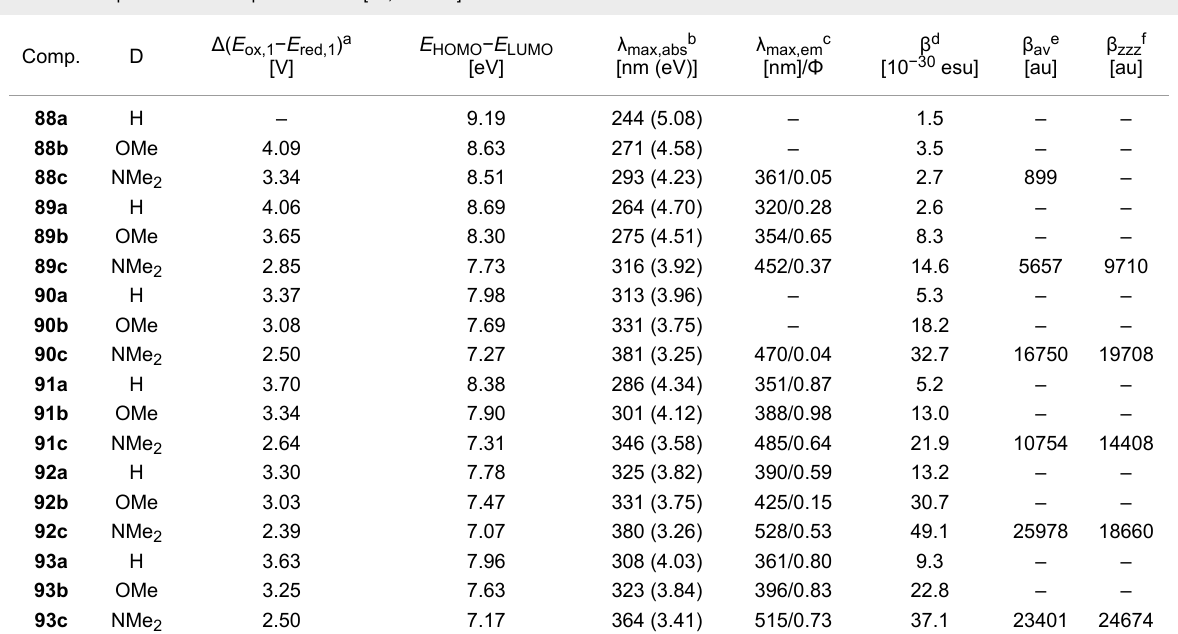
Table 10: Properties of chromophores 88 – 93 [30,108-110].